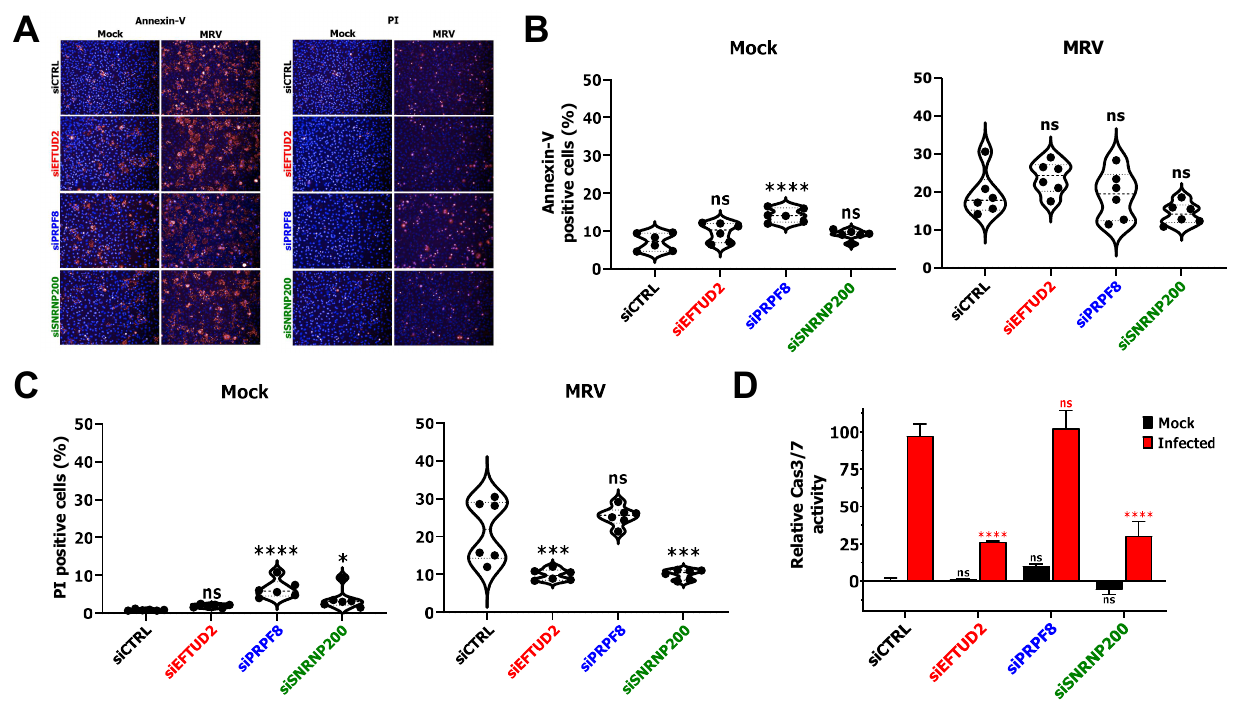
Figure 2. EFTUD2 and SNRNP200 depletion hamper apoptosis. ( A ) Representative set of images for the high-throughput multiplex microscopy-based apoptosis assay. On the left, Annexin-V signal is shown in red, representative of apoptotic cells. On the right, propidium iodide signal is shown in red, representative of dead cells. On both sides, the nuclei are stained with Hoechst and shown in